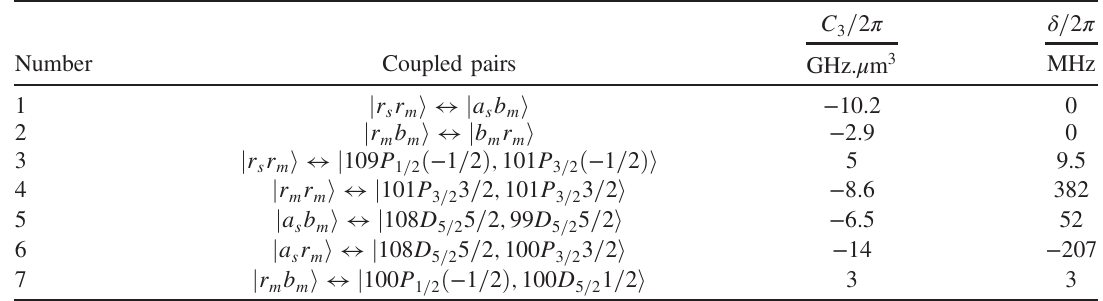
TABLE II. List of near-resonant Rydberg pairs. Subscripts s and m represent the single (e.g., target in Toffoli) and multiple atoms (e.g., controls in Toffoli).